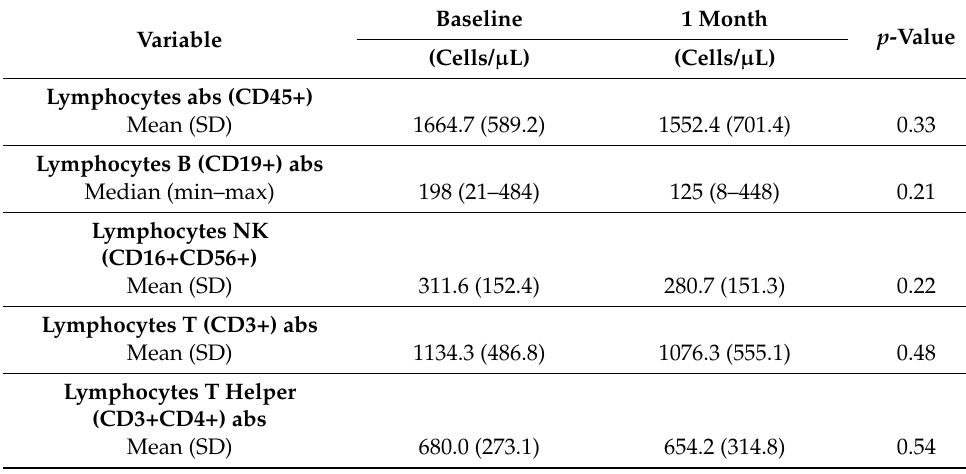
Figure 1. Study overview with key observation summary per drug. Table 2. Comparison of values between baseline and after 1 month of therapy.